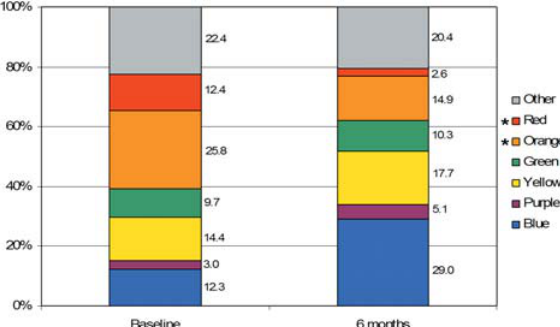
Figure 3- Mean proportions of microbial complexes (12) at baseline and at 6 months after coronally positioned (cid:17)(cid:2)(cid:13)<(cid:7)(cid:24)!(cid:5)(cid:7)(cid:14)(cid:15)(cid:18)(cid:10)(cid:15)(cid:19)(cid:8)(cid:2)(cid:10)(cid:8)(cid:5)(cid:7)(cid:9)(cid:3)(cid:7)(cid:16)(cid:15)(cid:3)(cid:3)(cid:5)(cid:6)(cid:5)(cid:10)(cid:8)(cid:5)(cid:14)(cid:7)(cid:26)(cid:2)(cid:14)(cid:7)(cid:4)(cid:5)(cid:14)(cid:4)(cid:5)(cid:16)(cid:7)(cid:29)(cid:14)(cid:15)(cid:10)(cid:18)(cid:7)(cid:4)!(cid:5)(cid:7) Wilcoxon signed-rank test